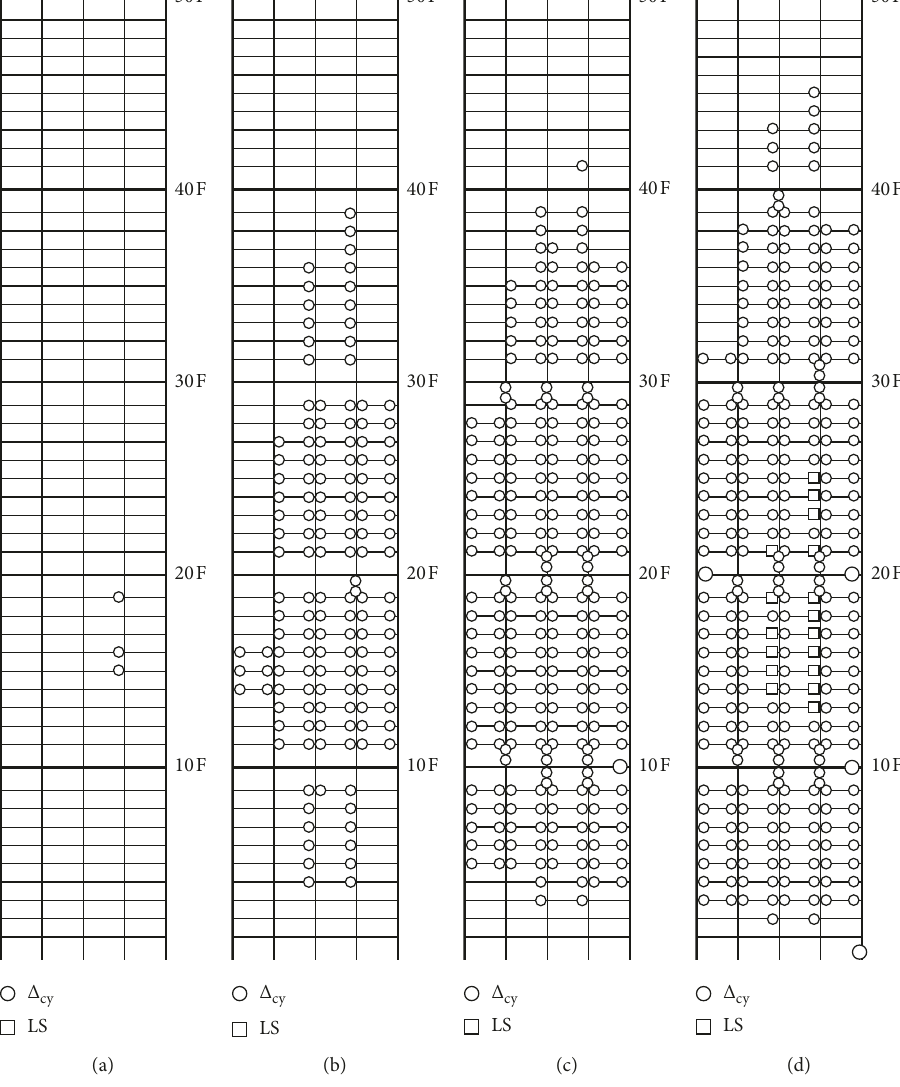
0.52%); (b) secondary column yield ( δ (cid:30)